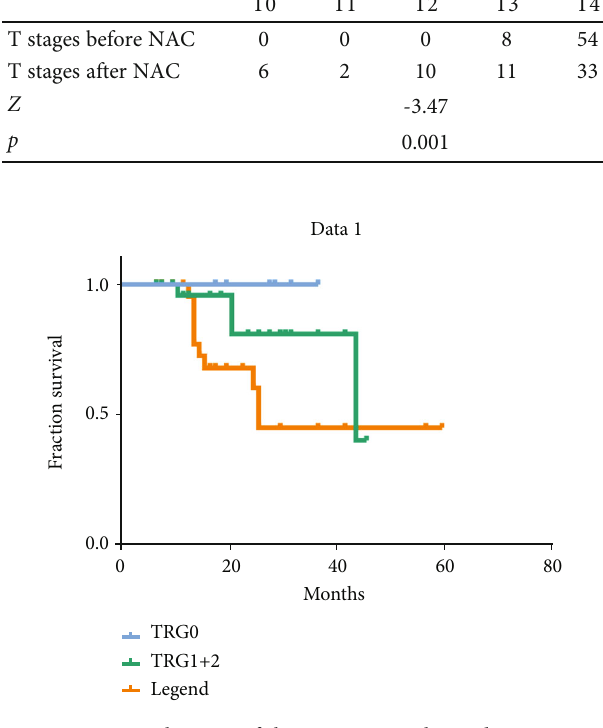
Figure 1: Survival curves of the 62 patients who underwent NAC and radical gastrectomy based on pathological regression grades. The X -axis denotes the survival time in months. TRG0 (blue curve) refers to the group with a signi fi cant pathological response, TRG1+2 (green curve) refers to the group with a partial pathological response, and TRG3 (orange curve) refers to the group with no pathological response. Table 4: Relationships between percentages of positive lymph nodes and TRG following NAC and